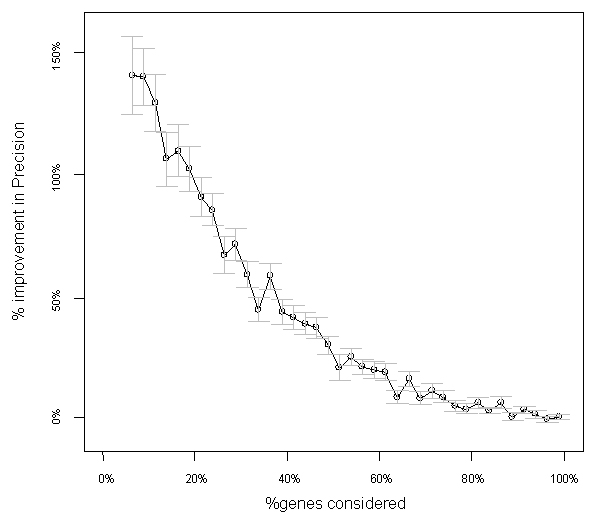
Improvement in Precision obtained using ranking. Per cent improvement in Precision obtained ranking genes and considering increasing percentage of them as belonging to identified modules.